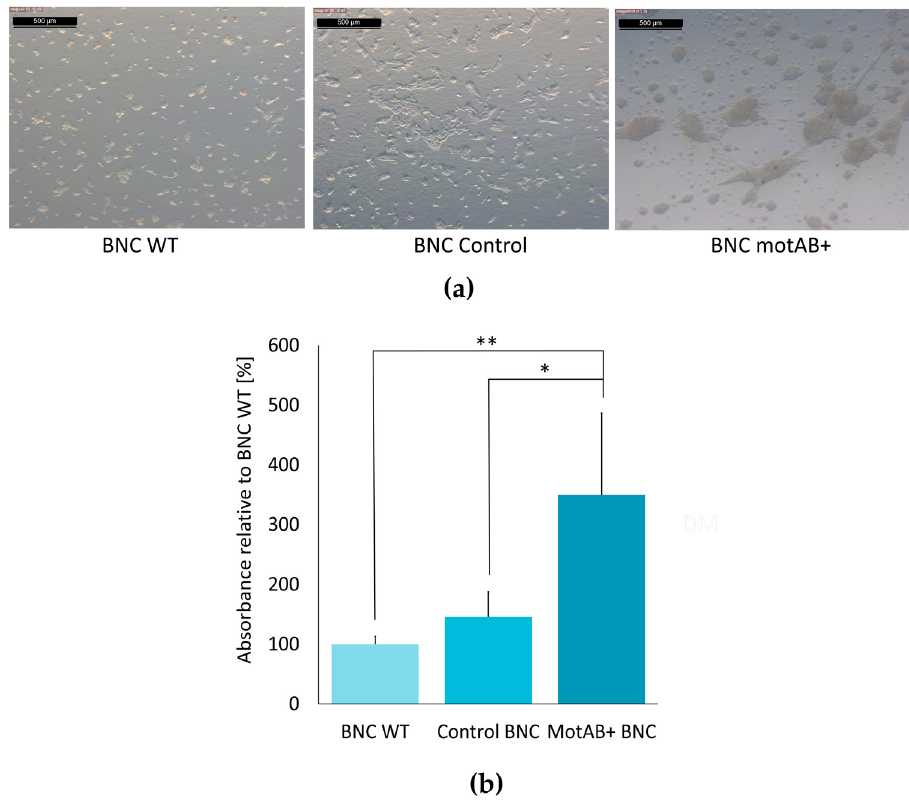
Figure 5. Chondrogenic-like behavior of ATDC5 cells cultured on BNC scaffolds produced by: wild type K. hansenii ATCC 23769 strain (WT BNC); control K. hansenii ATCC 23769 transformed with pTI99A (Ctrl BNC); mutant K. hansenii ATCC 23769 motAB+ strain (motAB+ BNC). ( a ) Morphology of ATDC5 cells observed under light M205 microscope, equipped with a Leica MC170 HD camera. Representative images (100 × magnification) from three-week long culture are shown. Scale bars correspond to 500 µ m; ( b ) Levels of glycosaminoglycan synthesis in Alcian blue stained ATDC5 cells. Bars on the graph represent levels of sample absorbance relative to absorbance of control cells seeded on BNC WT. Results obtained for BNC seeded cell corrected by subtraction of no-cell scaffold absorbance; Statistics: ** denotes p < 0.001; * denotes p <